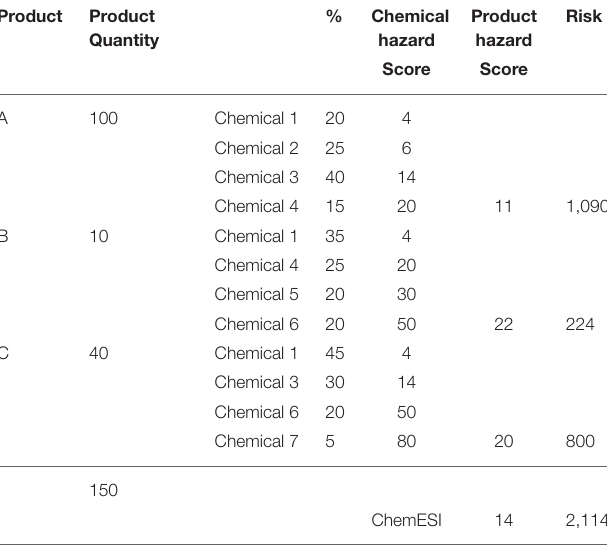
TABLE 3 | Product-based ChemESI